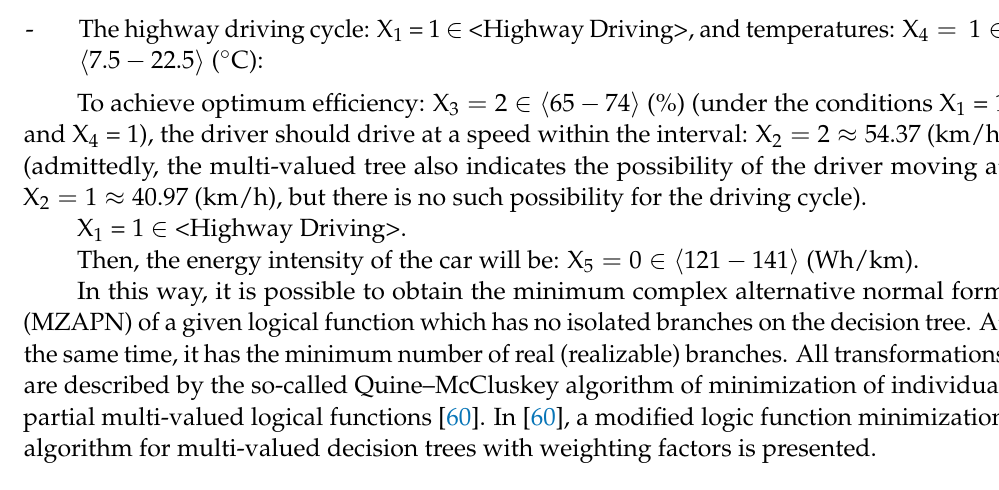
Figure 8. Block diagram of the electric vehicle drive system.